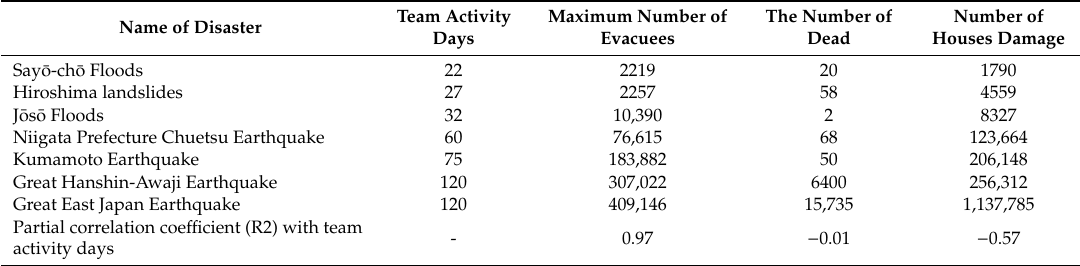
Table 2. The number of DMS activity days and major indicators of damages in large-scale disasters.